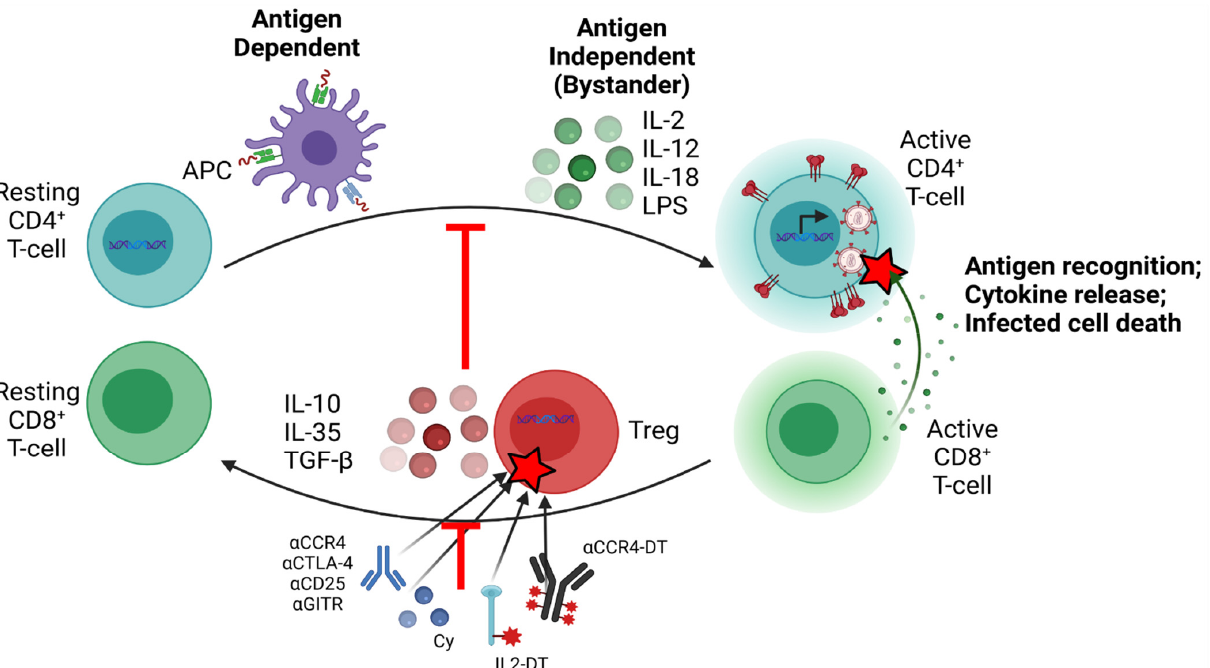
Figure 4. Treg depletion decreases suppressive signaling and allows for T cell activation and latency reactivation. Through the production of various cytokines and immune checkpoints, Tregs suppress other immune cells towards the resting state. By depleting Tregs with various agents, e.g., IL-2- diphtheria toxin or α CCR4, this should allow for activation of T cells to occur and thereby reactivate latent virus as well as bolster reservoir clearance by no longer impeding the cell-mediated immune